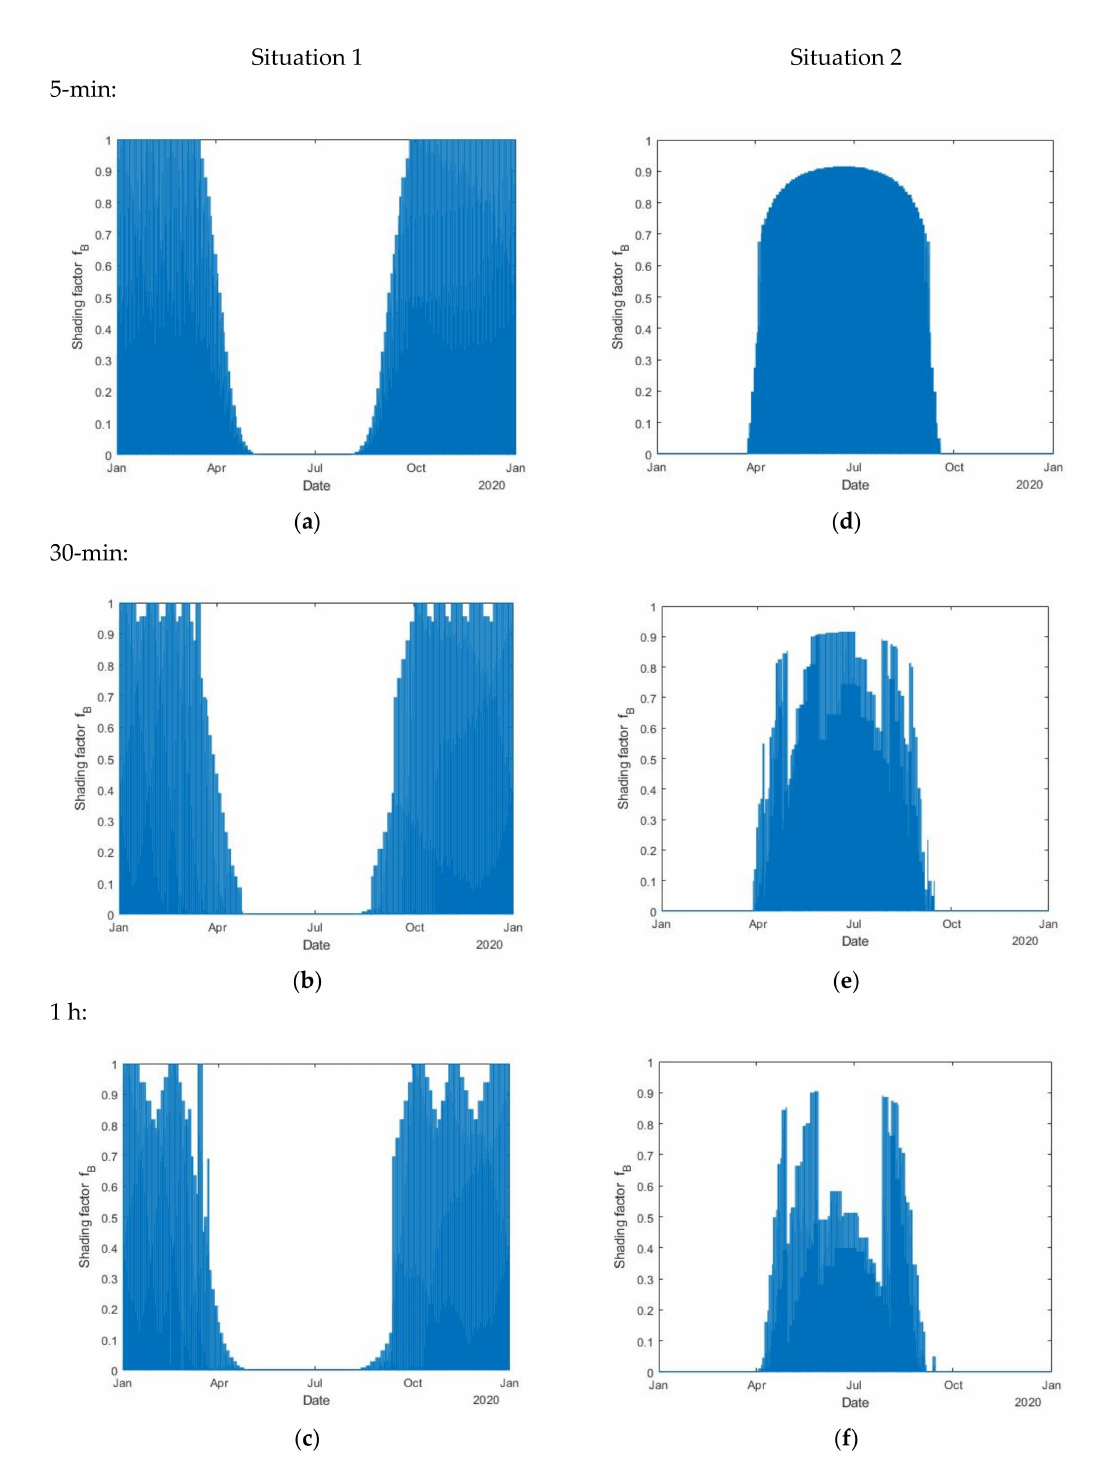
Figure 17. Effect of using different time steps when calculating the shading factor f B with Matlab. For situation 1: ( a ) 5 min; ( b ) 30 min and ( c ) 1 h. For situation 2: ( d ) 5 min; ( e ) 30 min and ( f ) 1 h. As the time step increases, the yearly curve of f B deteriorates and loses